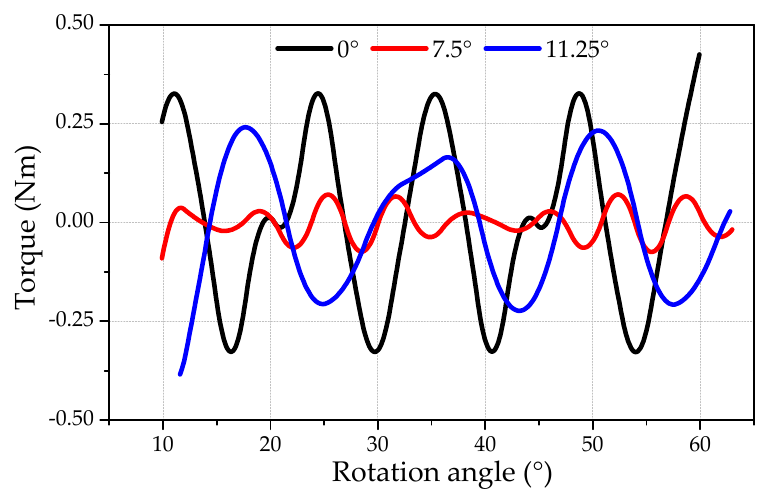
Figure 5. The magnetic field energy vs. the rotating angle for three relative angles between oppo- site teeth (0°, 7.5°, and 11.25°).